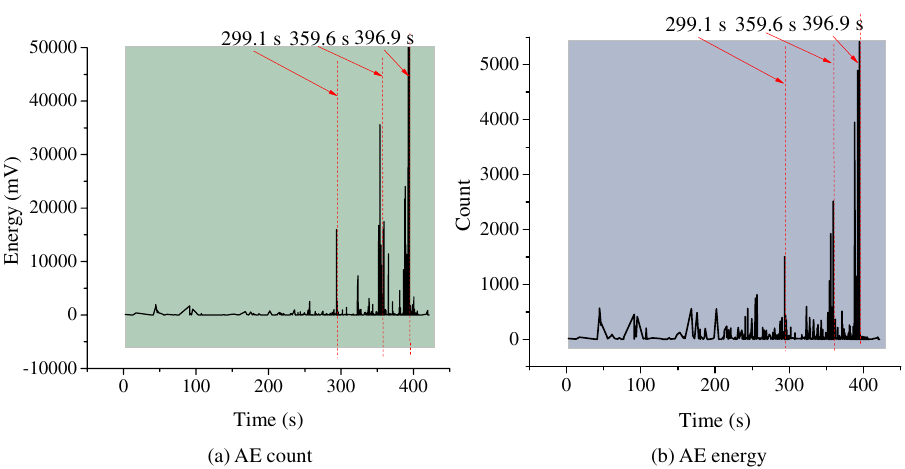
Figure 11. Experimental results of AE indexes during loading process of gas-bearing coal. ( a ) AE count. ( b ) AE